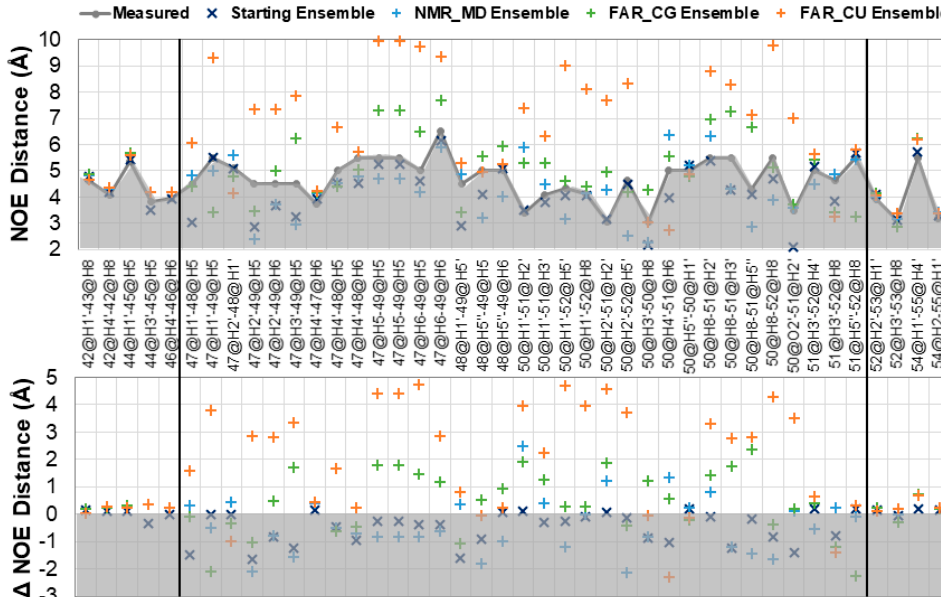
Figure 2. Evaluation of unambiguous nuclear Overhauser effect (NOE) assignments for starting SL2 ensemble, the molecular dynamics ensemble starting from 2L6I models (NMR_MD), the molecular dynamics ensemble starting from FARFAR2 predictions and sorted by central CG hydrogen bond (FAR_CG) or CU hydrogen bond (FAR_CU). Global NMR structure numbering is used for all ensembles in this figure. Top: Average < r 6 > values for ensembles along with the measured NOE data upper limit. Bottom: Deviation of ensemble < r 6 > averages from measured NOE. Grey areas reflect values which fulfil NOEs, as measured values were considered an upper distance limit. NOEs that fall between black bars reflect loop